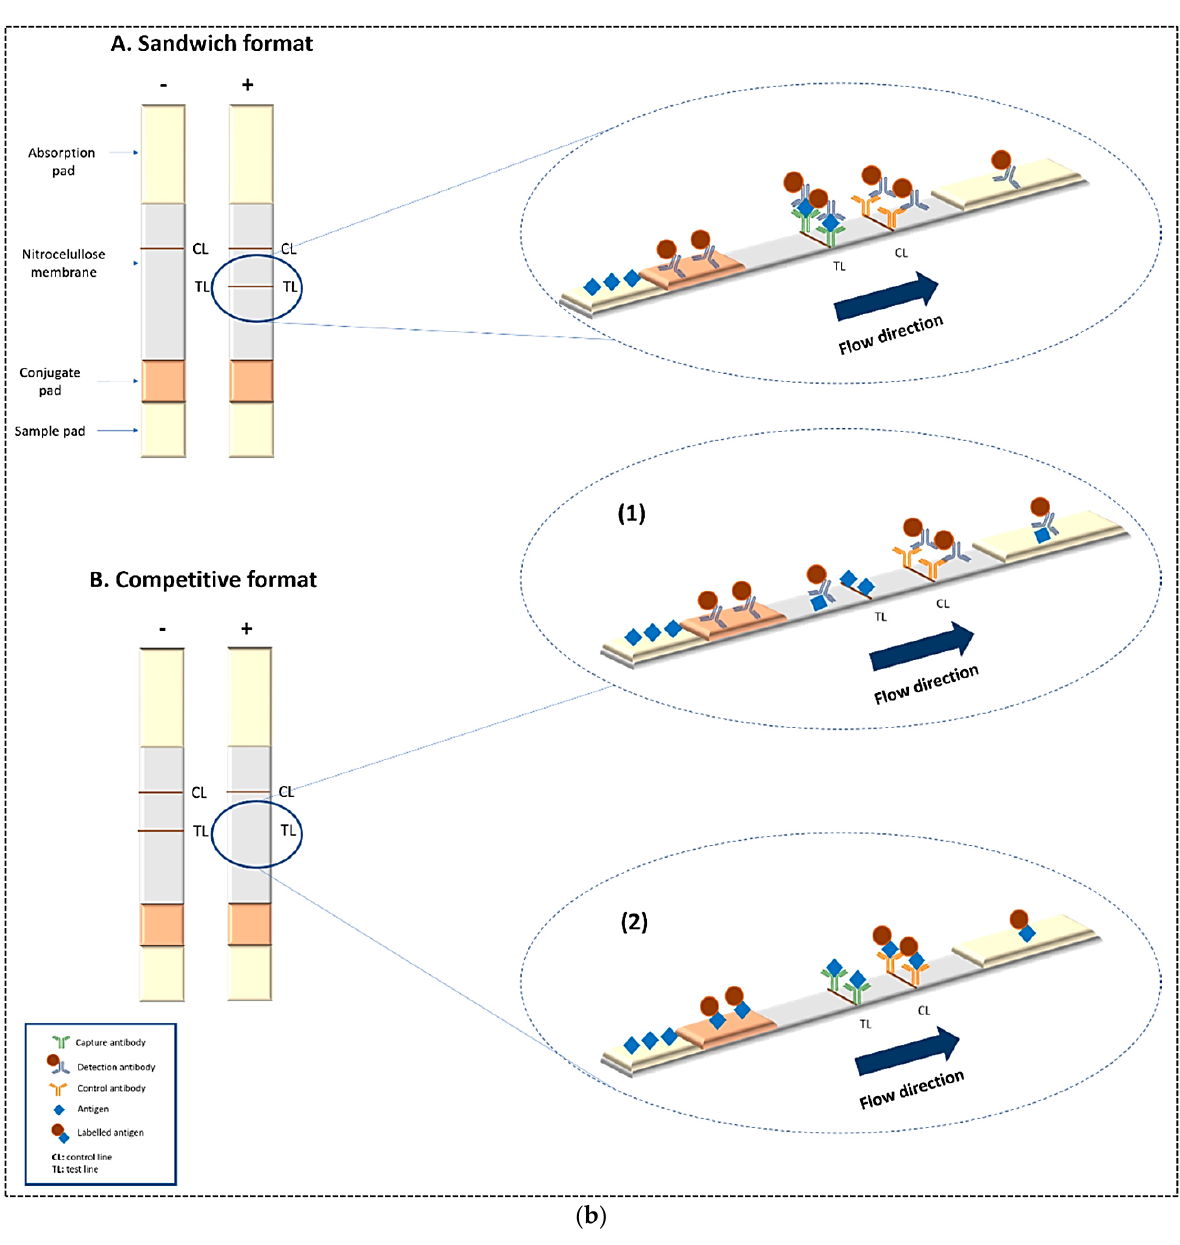
Figure 1. ( a ) Basic structure of a lateral flow test strip; ( b ) Principle of two common formats of LFA including sandwich and competitive formats. Reprinted with permission from [18,19] , respectively.